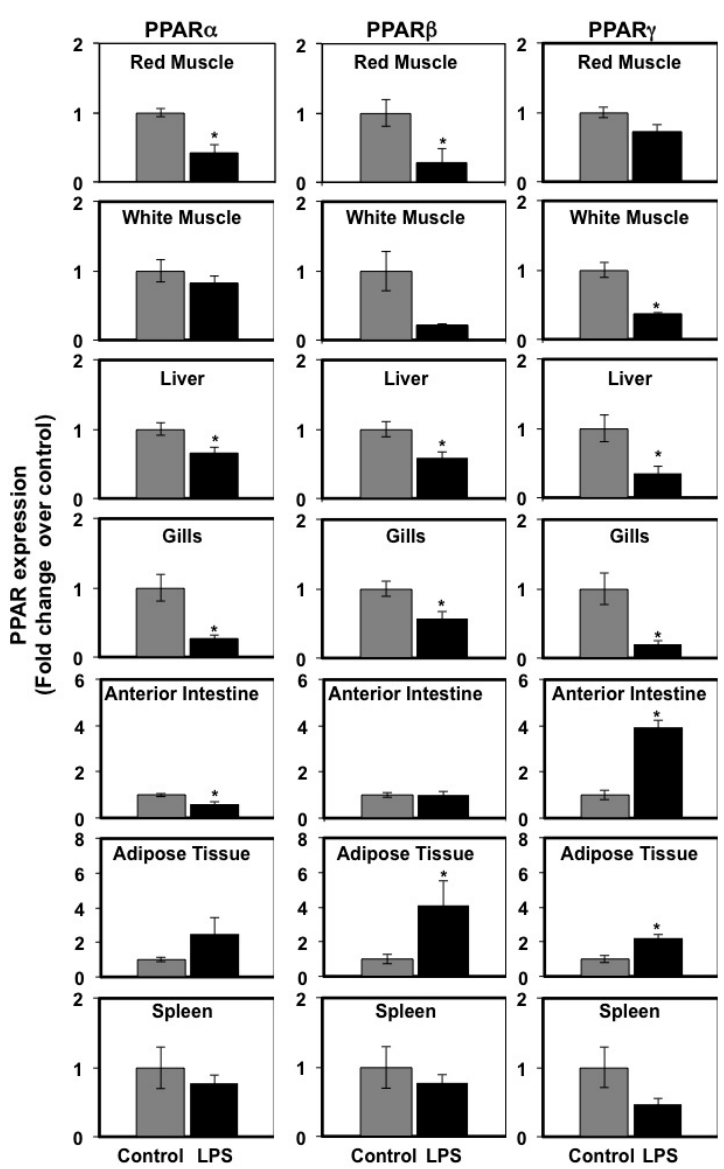
Figure 2. Effects of lipopolysaccharide (LPS) administration in vivo on PPAR gene expression in seabream tissues. The mRNA expression levels of PPAR α , PPAR β , and PPAR γ were measured by qPCR in seabream tissues at 72 h after LPS administration. Results are expressed as fold induction over the control (saline-injected) group, which was set to 1, and shown as means ± SE of five fish per group, with each sample performed in triplicate. Asterisks indicate significant differences from the control ( p < 0.05).